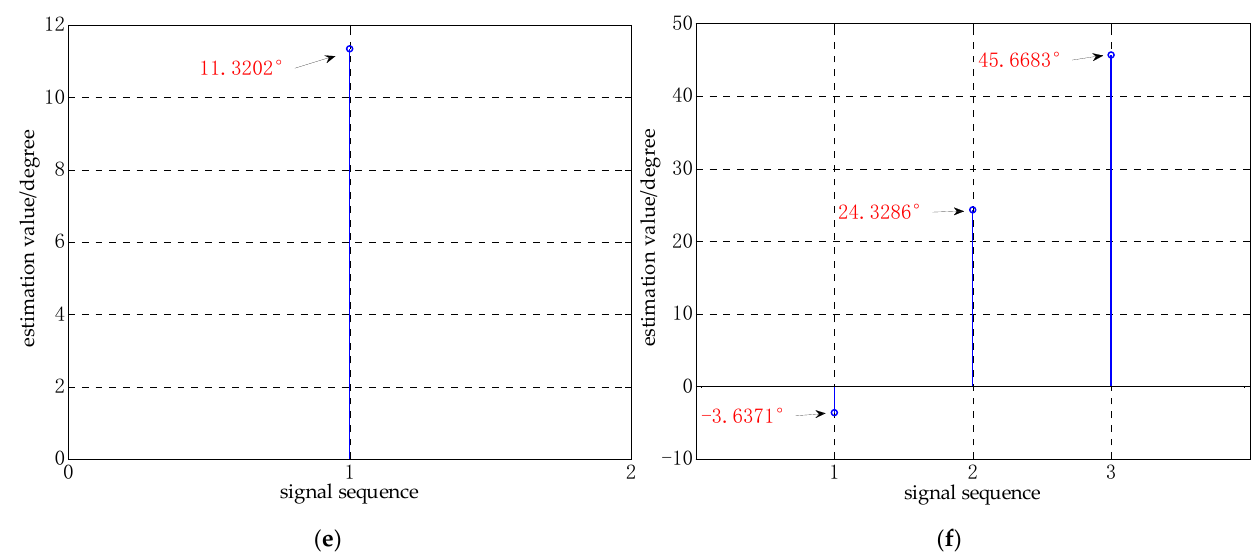
Figure 8. DOA estimation experiments for different algorithms (snapshots = 10, SNR = − 10dB). ( a ) CS-DOA-DBSCAN for single source signal, ( b ) CS-DOA-DBSCAN for multi-source signal, ( c ) MUSIC for single source signal, ( d ) MUSIC for multi-source signal, ( e ) TLS-ESPRIT for single source signal, ( f ) TLS-ESPRIT for multi-source signal.